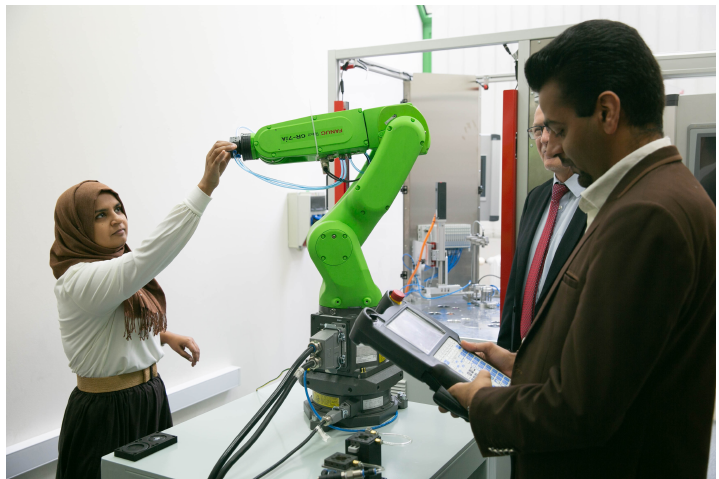
Figure 9. Experimental setup at